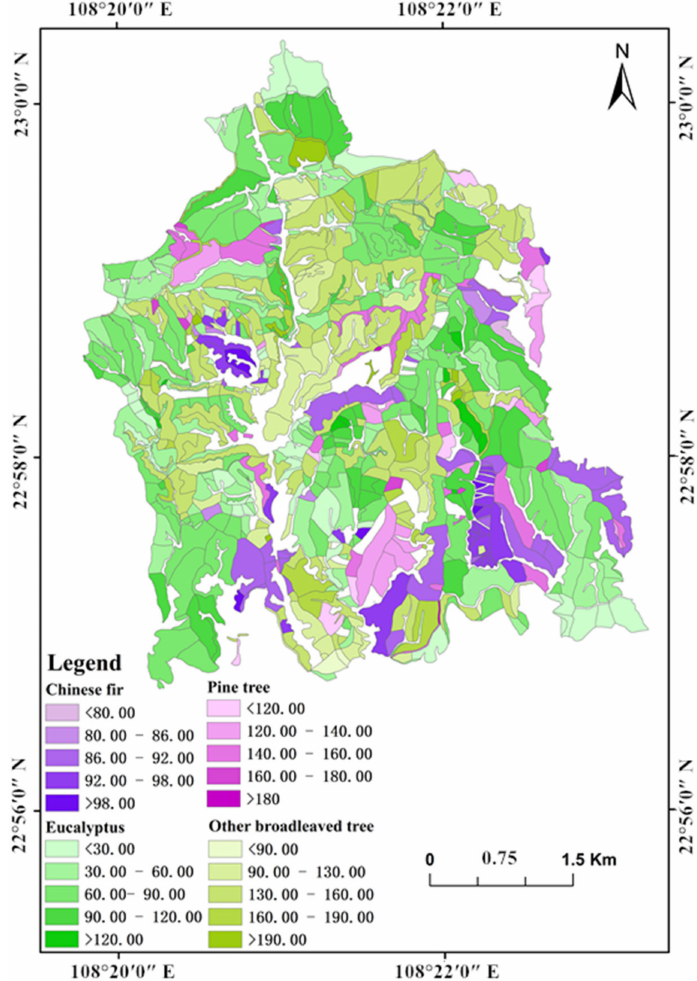
Figure 6. Forest above-ground biomass distribution in the study area.